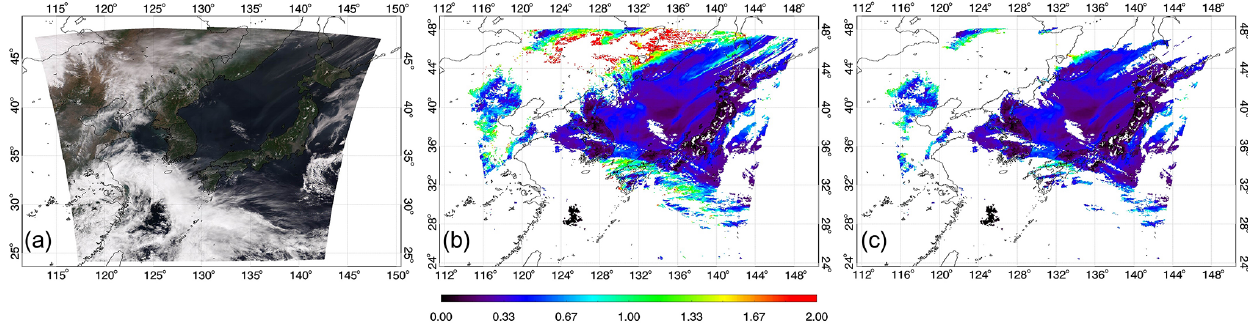
Figure 1. The case of 22 May 2016, 13:30LT: (a) true color image, (b) GOCI YAER V2 AOD without additional cloud masking, and